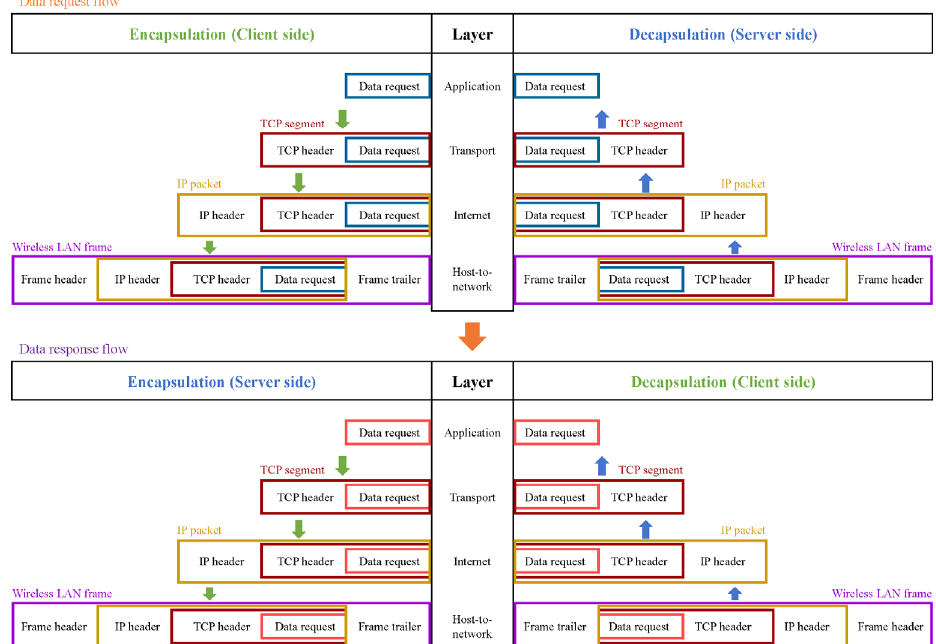
Figure 4. Application of TCP/IP model in the data flow.